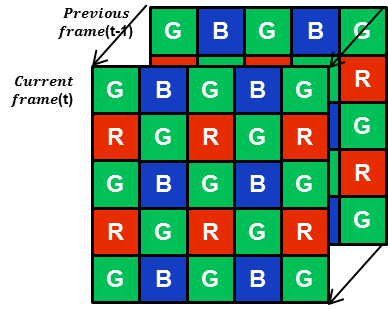
Figure 2. CFA Sequence to be denoised.